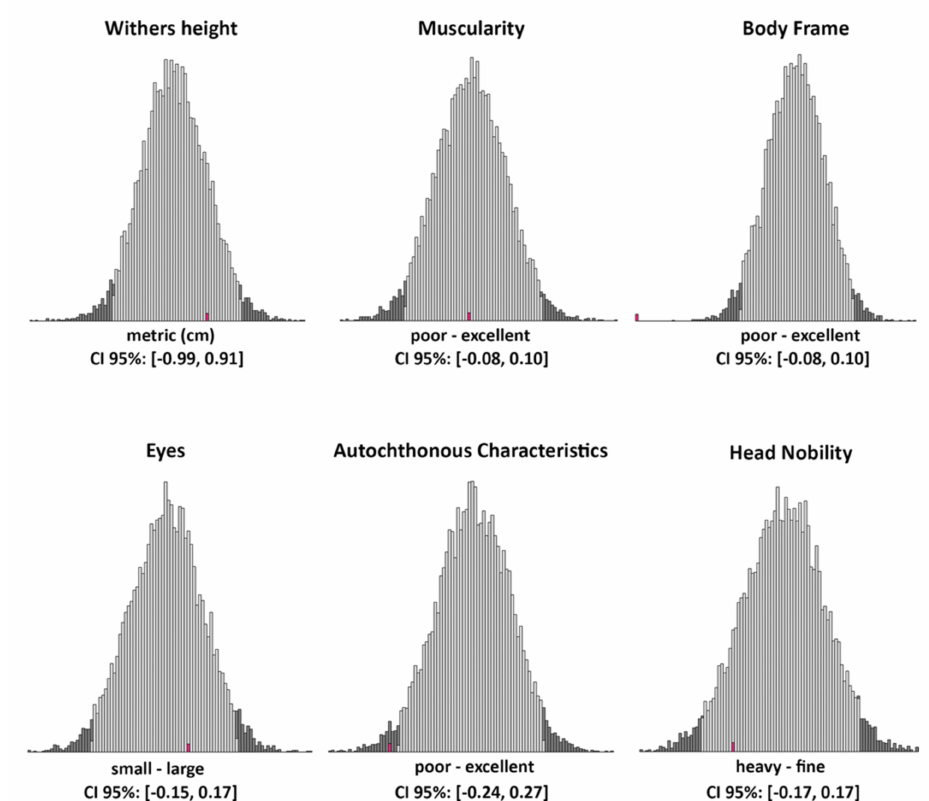
Figure 7. Distributions of the mean breeding values for the sample of 44 animals without the “mutation” (10,000 samples) with credibility intervals (grey bars) for six type traits important in the breeding of Cika cattle. The mean of the breeding values for 44 animals with the “mutation” is shown in